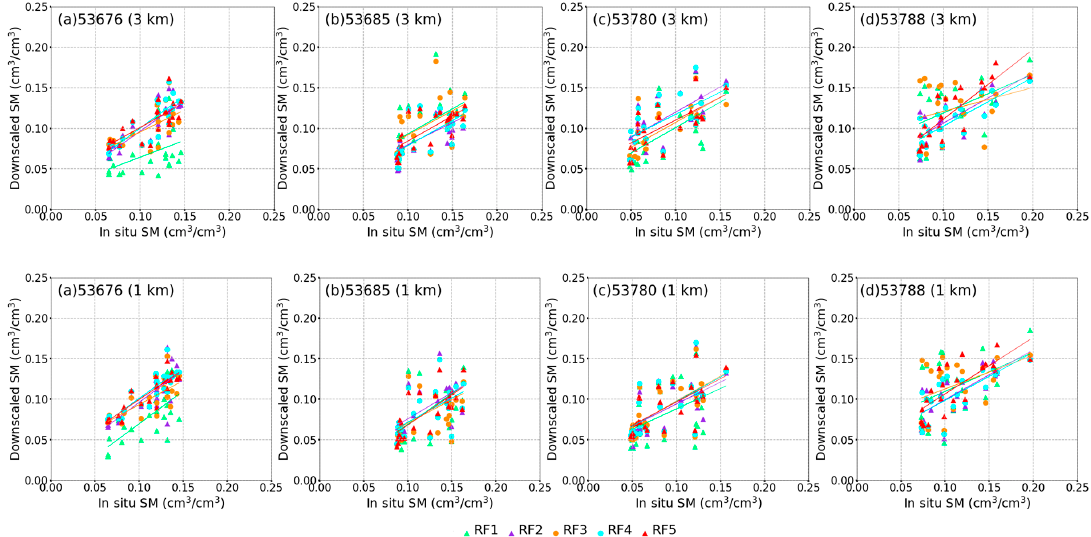
Figure 5. Scatter plots of downscaled SM estimates based on RF1–RF5 at 3 km (first row) and 1 km (second row) vs. point-scale in situ SM measurements. The results are shown for each station: 53676 (first column), 53685 (second column), 53780 (third column), and 53788 (fourth column). Table 2. Results comparison summary for the 3 km downscaled SM based on RF1–RF5 vs. in situ SM. The number of samples at stations 53676, 53685, 53780, and 53788 is 22, 21, 20 and 20, respectively. Avg is short for average.